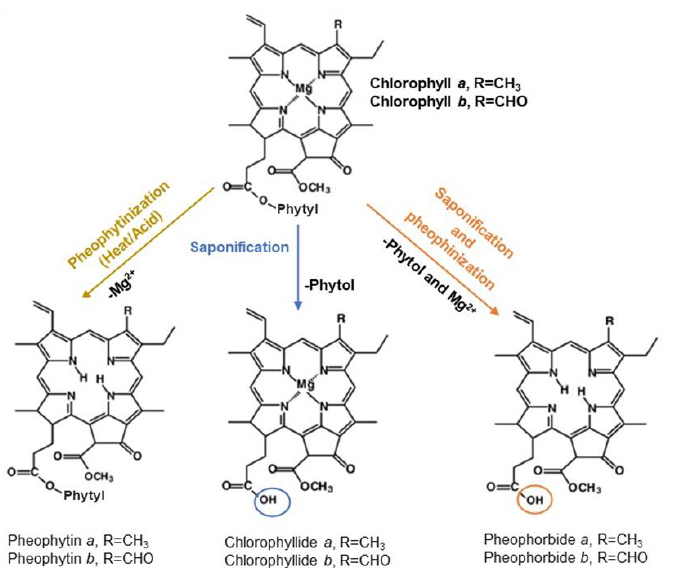
Figure 1. Major Chl a and Chl b degradation routes through pheophytinization and